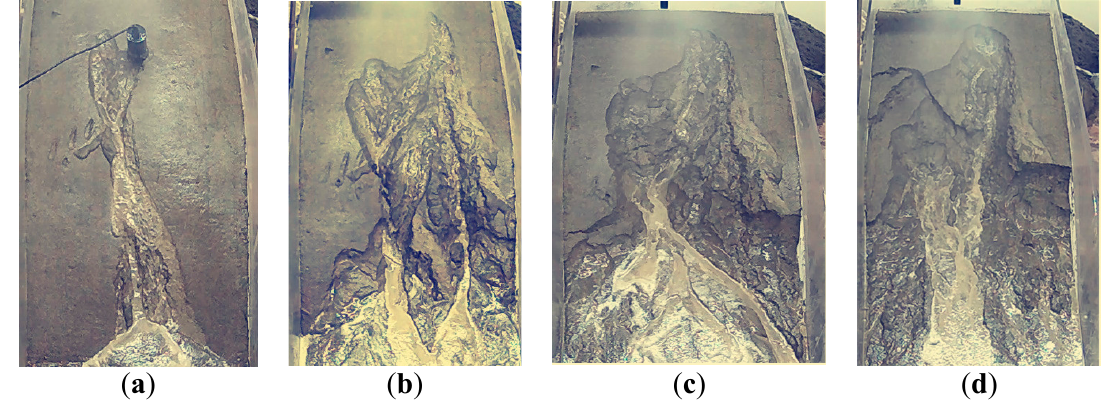
Figure 4. Different time domains in Sample 1 and rainfall intensity-65 mm/h test: